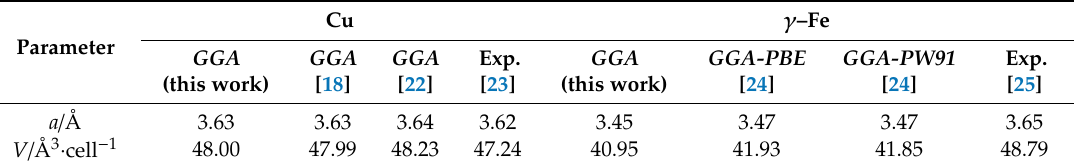
Table 1. The lattice constants and cell